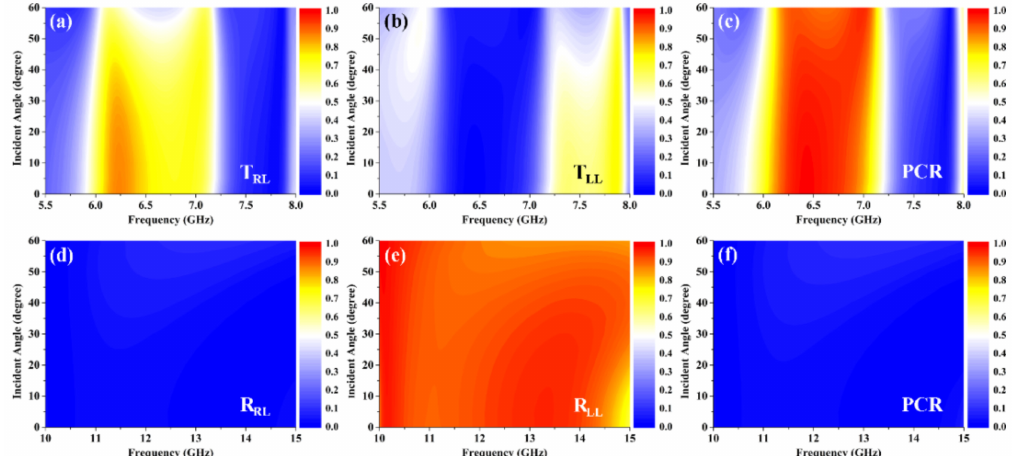
Figure 8. Influences of incident angle on the electromagnetic properties of the metagrating in the case of circular polarization incidence. ( a ) Cross-polarization transmittance, ( b ) co-polarization transmittance, and ( c ) PCR in transmission mode; ( d ) cross-polarization reflectance, ( e ) co-polarization reflectance, and ( f ) PCR in reflection